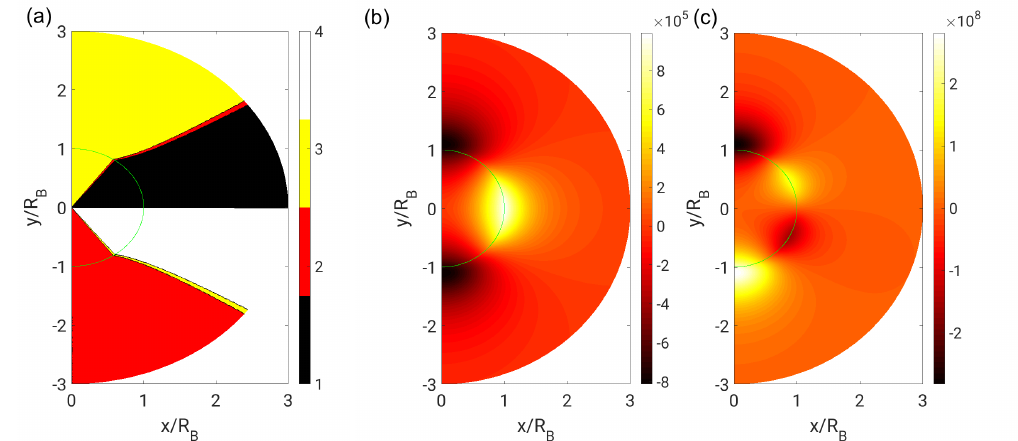
Figure 6. ( a ) Flow topologies; ( b ) second invariant Q ; and ( c ) third invariant R in the neutral case ( ξ = 1) with far-field boundary conditions.